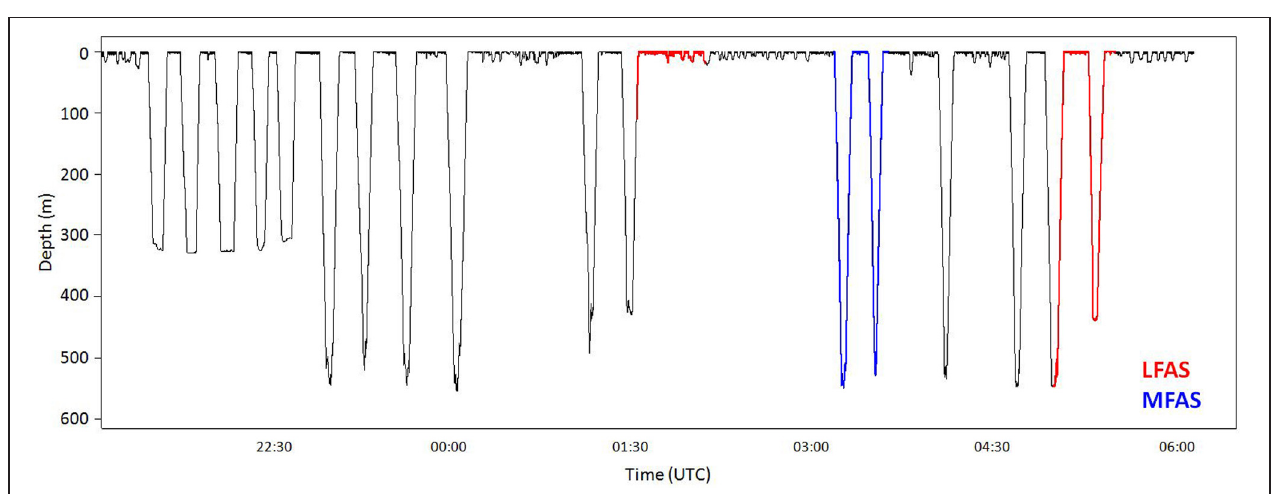
conducted both shallow and deep dives. During the second LFAS exposure, the whale was shallow diving before sonar onset, and continued shallow diving with one occasional deep dive.